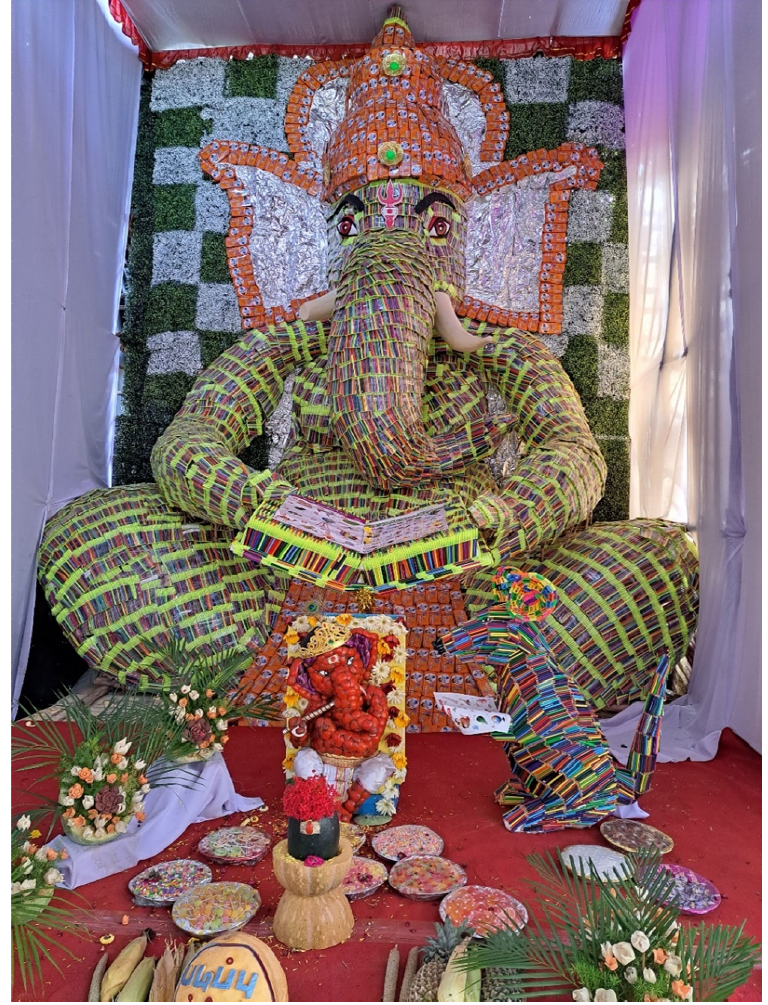
Figure 6. Ecofriendly pencil Ganesha and his vimana (vehicle) in Manali. Picture taken by author, 1 September 2022,